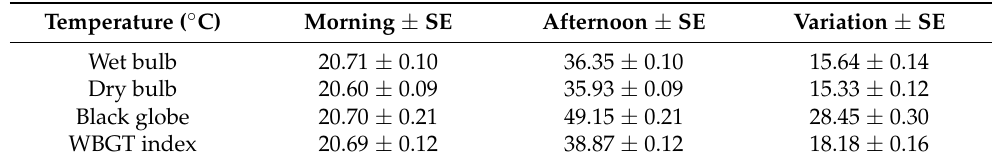
Table 1. Least squares means and standard errors (SE) from environmental conditions obtained at the paddock before (morning) and after (afternoon) sun exposure ( p < 0.0001). Temperature ( ◦